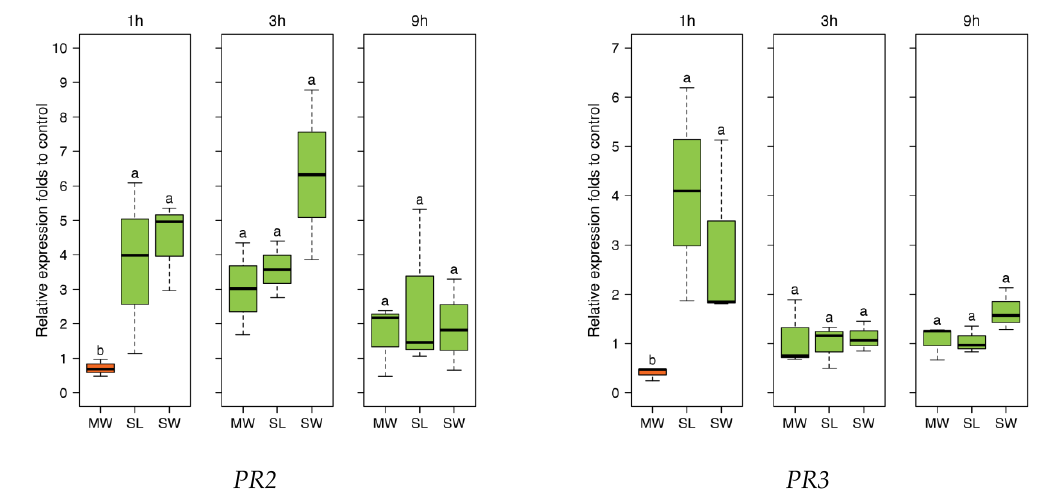
Figure 9. Expression of four JA responsive genes ( LOX3 , PAL , PR2 , and PR3 ). Lima beans treated for 1 h, 3 h, and 9 h with MecWorm (MW), S. littoralis (SL), and SpitWorm (SW). Phaseolus lunatus’s actin housekeeping gene ( PACT1 ) served as normalizer. (SW; 1:10 diluted OS, delivery speed of 10 nL·s − 1 ); n = 3 for each treatment; log2 transformed; one-way ANOVA; post-hoc test: Fisher’s LSD; treatments with identical letters are not significantly different.